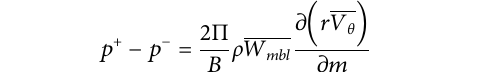
Figure 8 is the distribution law of impeller blade loading, which has three parts, that is, the parts of the leading and trailing edges are parabolic, and the middle part is linear. In the